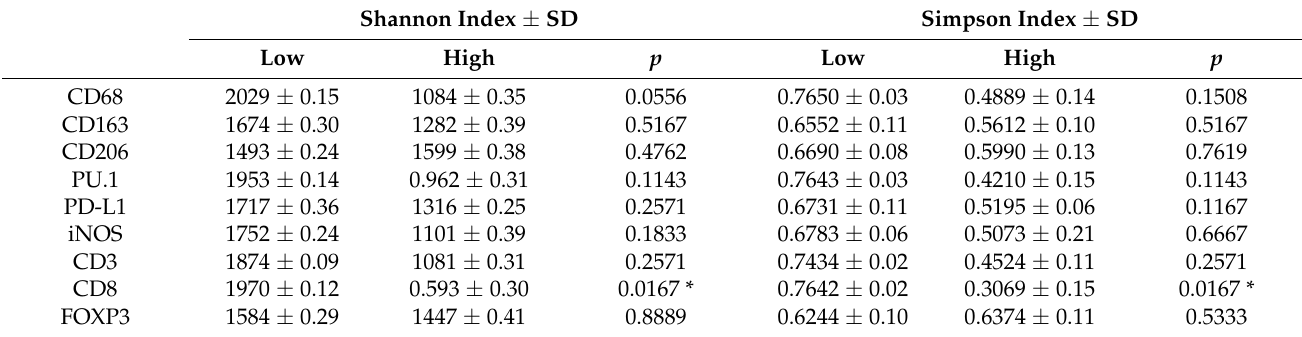
Table 3. Analysis of α -diversity depending on the phenotype of the inflammatory infiltrate.